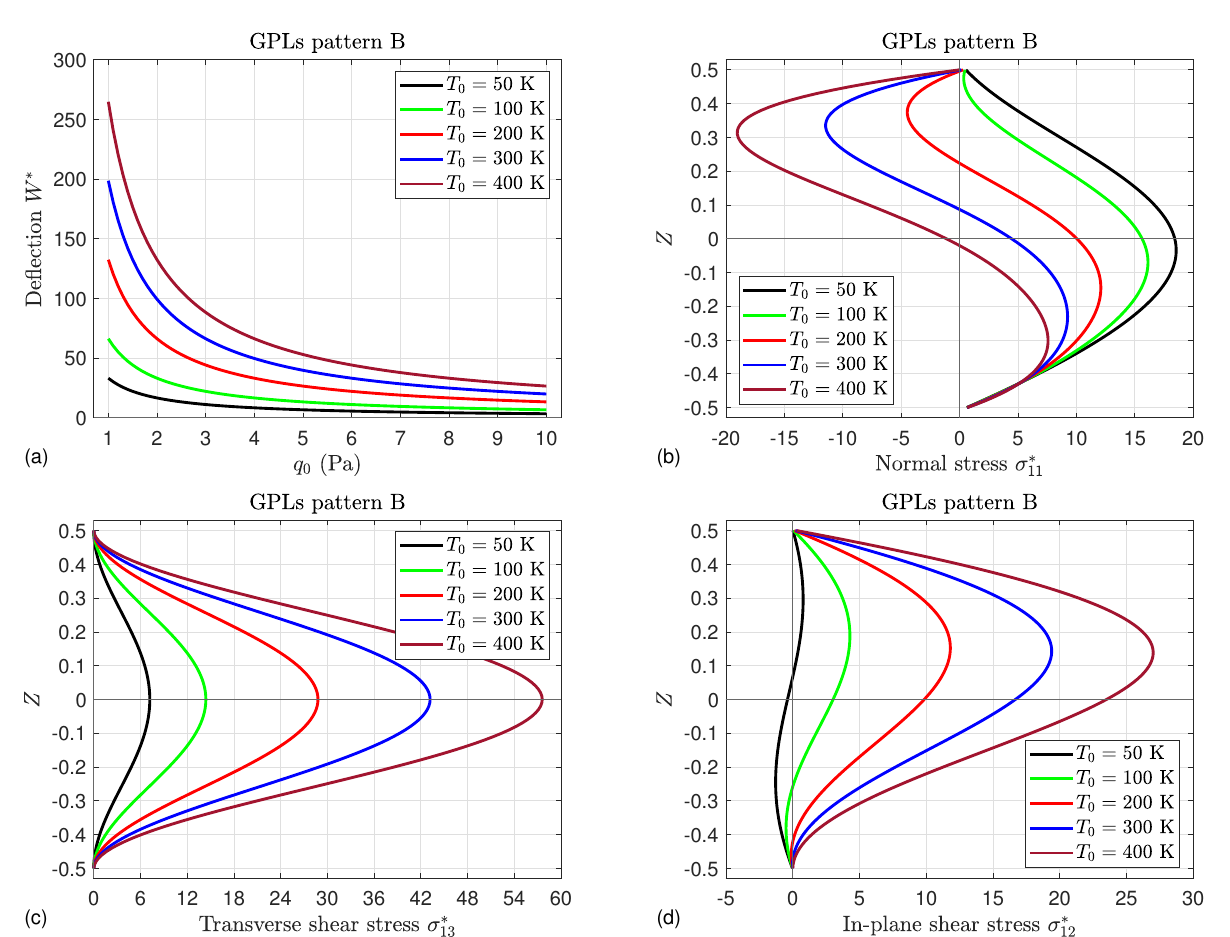
Figure 12. Influence of the temperature parameter T 0 on the ( a ) central deflection W ∗ , ( b ) normal stress σ ∗ , ( c ) transverse shear stress σ ∗ 11 piezoelectric square